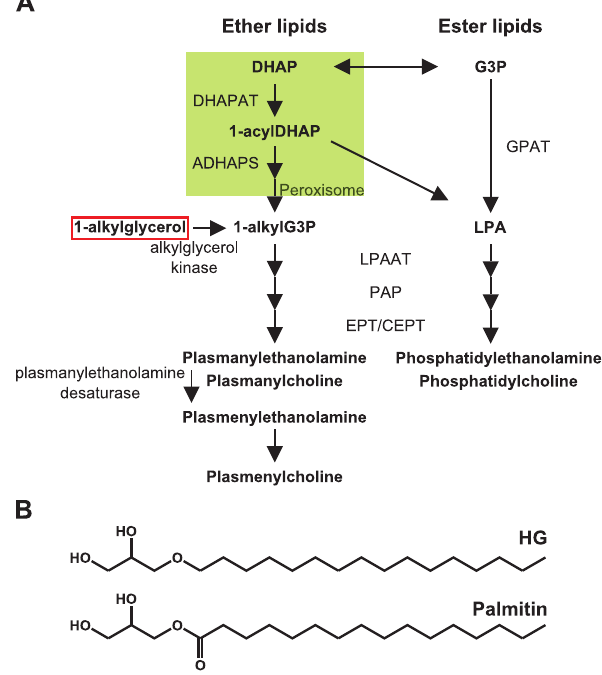
Figure 1. Biosynthesis of ether and ester glycerophospholipids and the chemical structures of the precursors used. ( A ) Schematic overview of the biosynthesis of ether and ester glyceropho- spholipids. Note that 1-alkylglycerols such as HG (red box) may enter the pathway through phosphorylation to 1-alkylglycerol 3-phosphate by an alkylglycerol kinase. For abbreviations of the compounds and enzymes, see below. ( B ) The chemical structure of the compounds used in this study, HG and palmitin. DHAP; dihydroxyacetone phosphate, G3P; glycerol 3-phoshpate, DHAPAT; dihydroxyacetone phosphate acyltransferase, GPAT; glycerol phosphate acyltransferase, ADHAPS; alkyldihydroxyacetone phosphate synthase, LPA; lysophosphatidic acid, LPAAT; lysophosphatidic acid acyltransferase, PAP; phosphatidic acid phosphatase, EPT; ethanolamine phosphotransferase, CEPT; choline/ ethanolamine